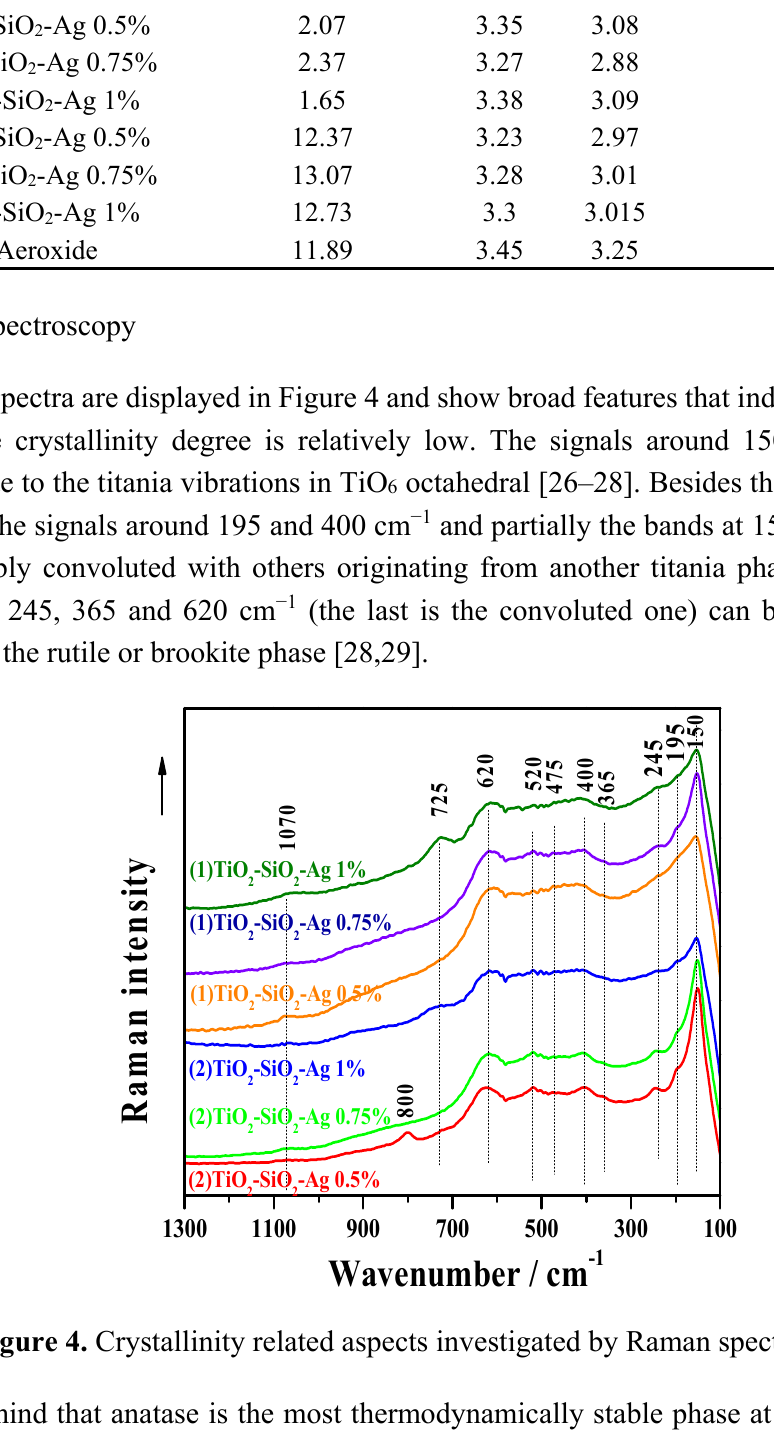
Table 1. Photocatalytic efficiencies and morpho-structural properties of TiO 2 -SiO 2 -based composites. Sample